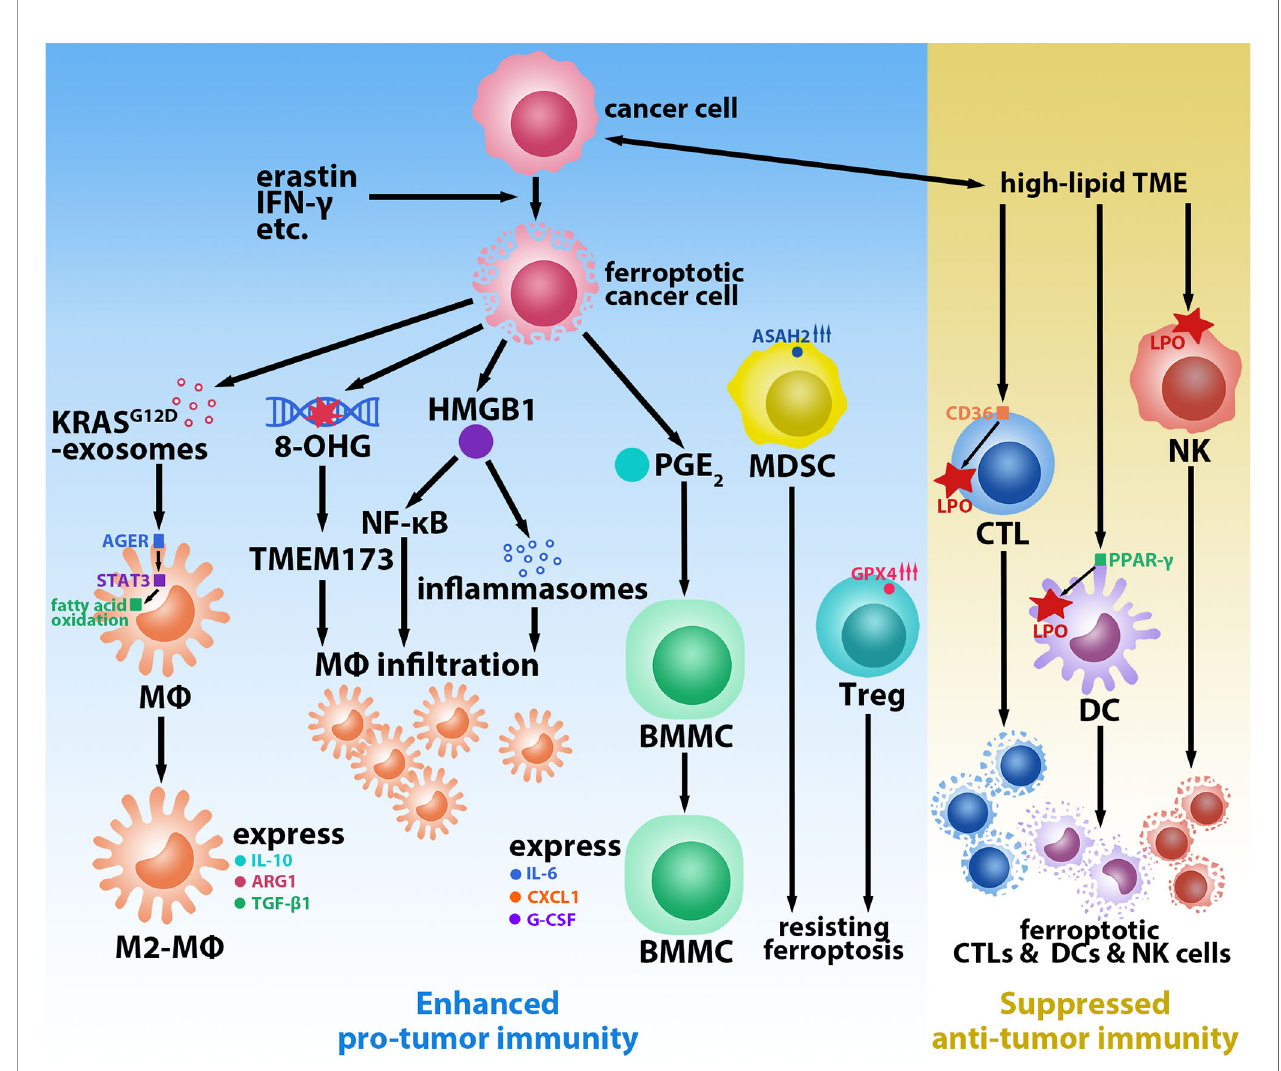
FIGURE 1 | Ferroptosis-mediated tumor-promoting immune microenvironment. Ferroptotic cancer cells induced by erastin, IFN- g , etc. promote macrophages (M F s) in fi ltration and M2-polarization via releasing Kras G12D -exosomes, 8-hydroxyguanosine (8-OHG), high-mobility group box 1 (HMGB1), and prostaglandin E 2 (PGE 2 ). Regulatory T cells (Tregs) and myeloid-derived suppressor cells (MDSCs) resist ferroptosis by upregulating glutathione peroxidase 4 (GPX4) and N -acylsphingosine amidohydrolase (ASAH2), respectively. High-lipid conditions in the tumor microenvironment (TME) induce ferroptosis of cytotoxic T lymphocytes (CTLs) via CD36, natural killer (NK) cells, and dendritic cells (DCs) via peroxisome proliferative activated receptor- g (PPAR- g ) by promoting lipid peroxidation